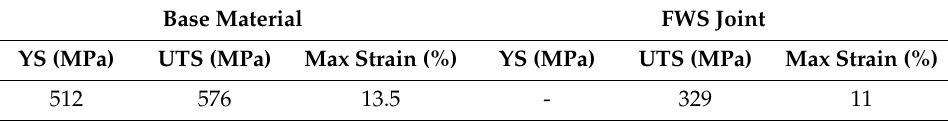
Table 2. Mechanical properties of the base materials and the welded